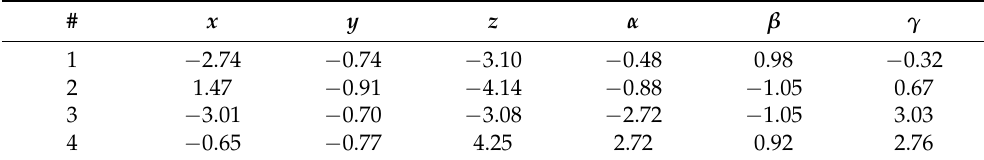
Table 1. Binding locations between HBcAg 2 from the reference capsid (see Figure 1). Positions with respect to the body frame of the reference (molecule A) on x -, y -, z -axis are in nanometer, while angles α , β , γ are in